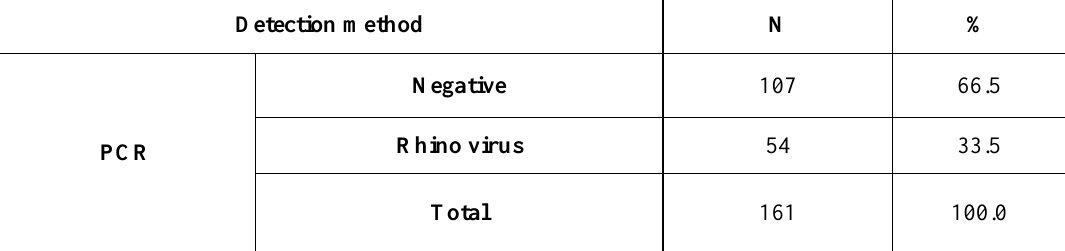
Table 2. Detection of HRV by RT-PCR in nasopharyngeal specimens.